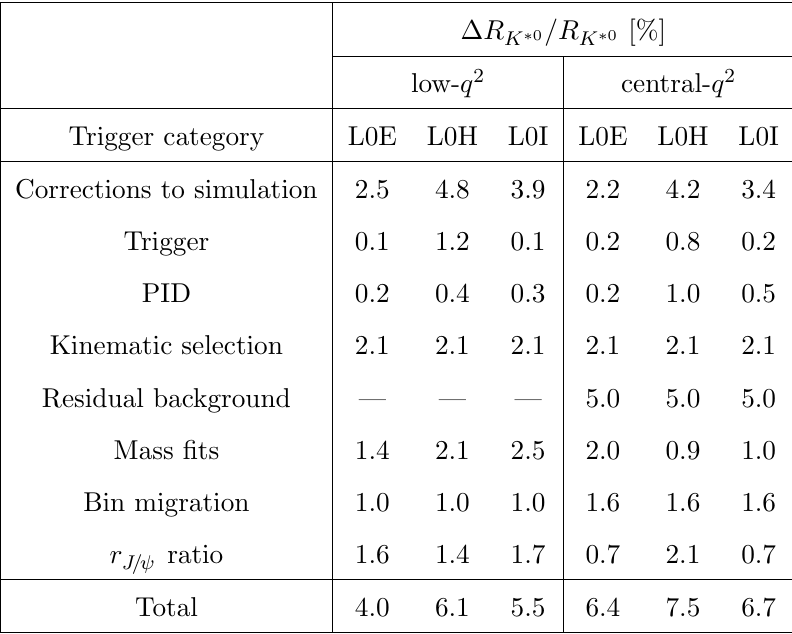
Table 4 . Systematic uncertainties on the R ratio for the three trigger categories separately (in K (cid:3) 0 percent). The total uncertainty is the sum in quadrature of all the contributions. and electron channels, this is not the case at low- q 2 due to the di(cid:11)erence in lepton masses; the distribution of the distance between the K + (cid:25) (cid:0) and ‘ + ‘ (cid:0) vertices shows that the pairs of hadrons and leptons consistently originate from the same decay